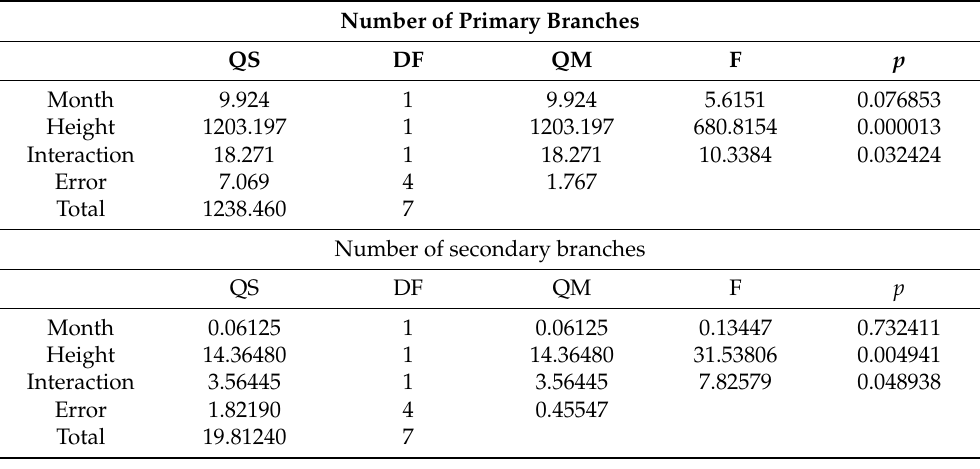
Table 2. ANOVA responses for number of primary and secondary branches.